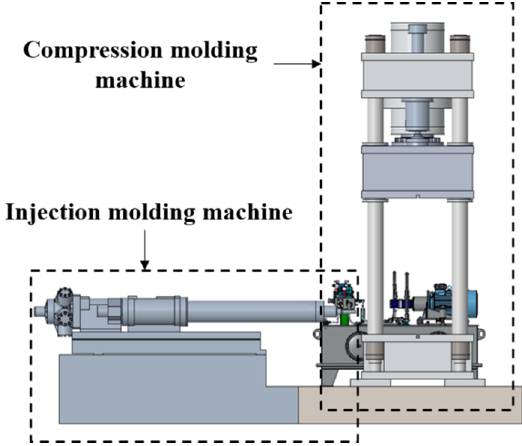
Figure 21. Schematic of hybrid molding machine. Injection analysis was performed on the center pillar with the composite reinforce- ments to select the injection gate position and evaluate the safety of the injection